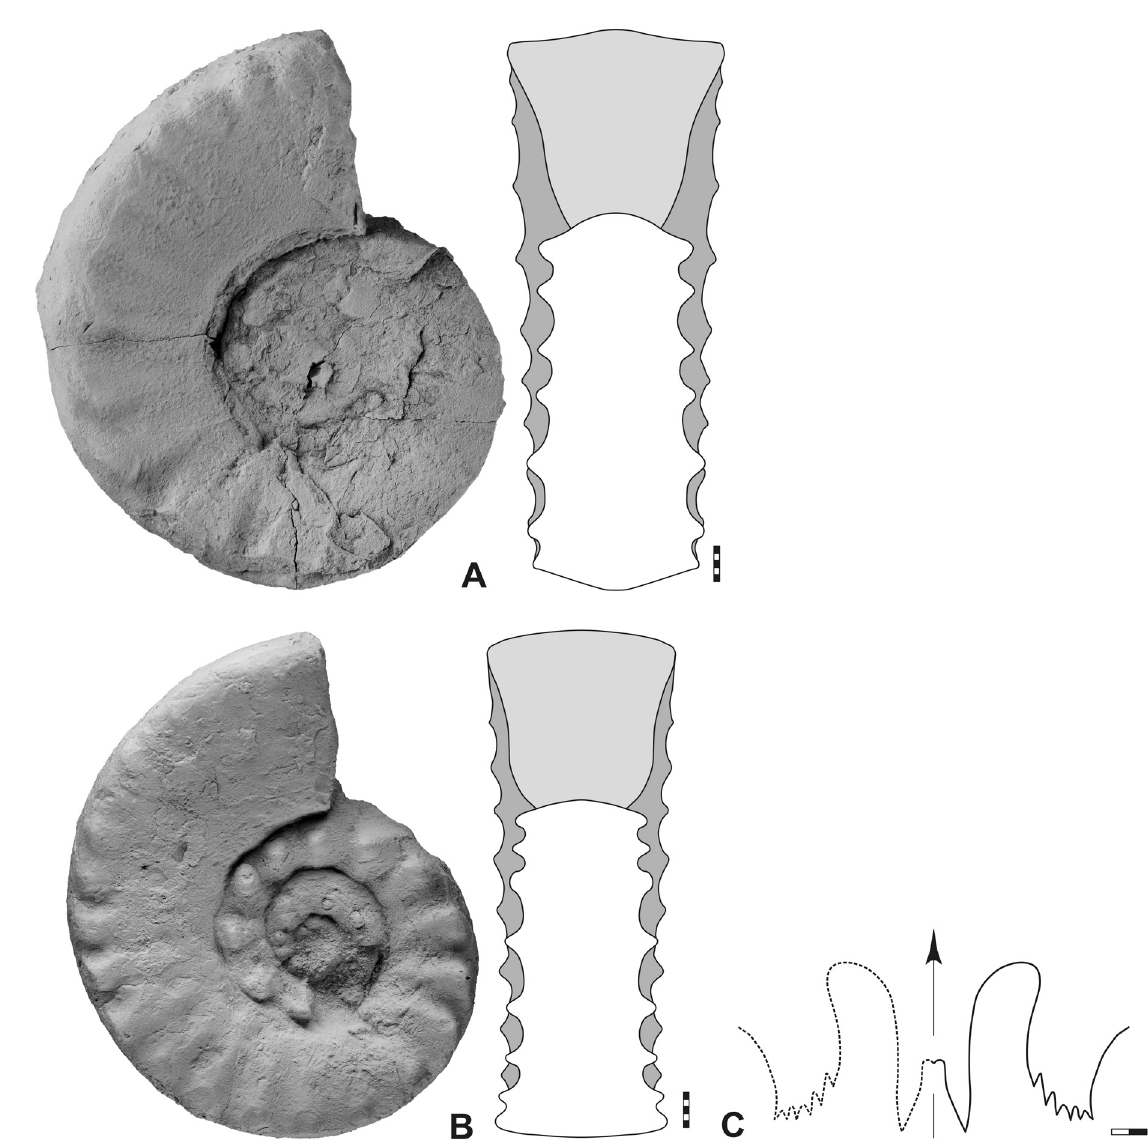
Fig. 32. Paratirolites trapezoidalis Shevyrev, 1965. A–B . Lateral and dorsal views. A . Specimen MB.C.29845, section E, -2.80 m. B . Specimen MB.C.29844, section E, float. C . Suture line of specimen MB.C.29844, at 13.3 mm wh. Abbreviation: see Material and methods. Scale bar units = 1 mm.